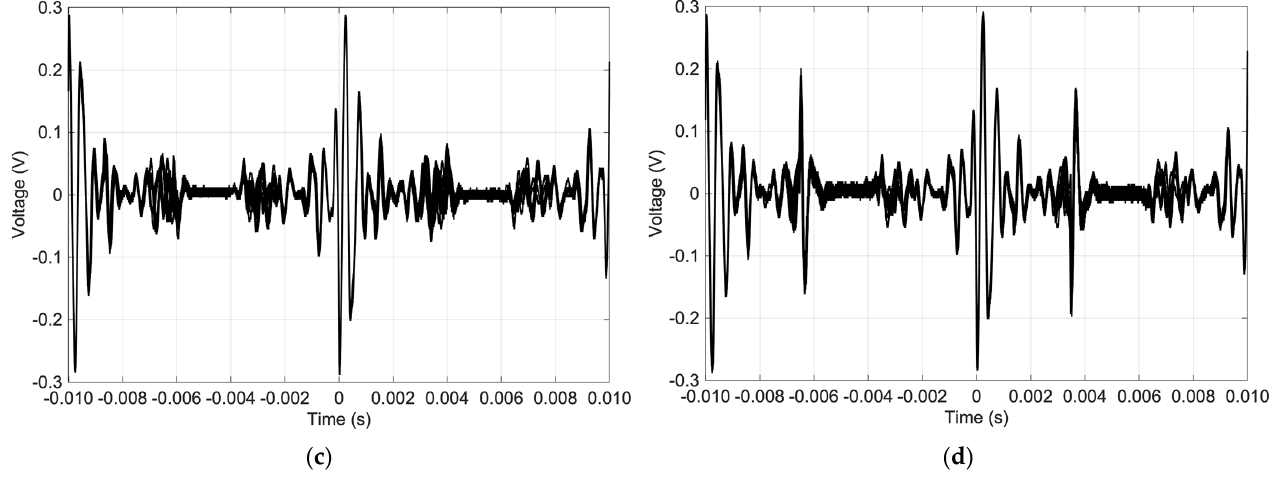
Figure 9. Ten successive 20 ms windows overlapped to show time variability of waveform portions: ( a ) Lacie Black P25, ( b ) Lacie Black P90, ( c ) KTEC P25 and ( d ) KTEC P90.